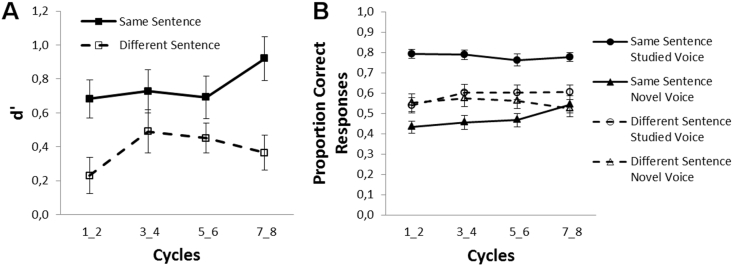
Voice recognition performance as reflected in (A) mean sensitivity d′ and (B) proportion correct responses depicted for sentence conditions and pairs of cycles (and voice novelty conditions). Error bars are standard errors of the mean (SEM).